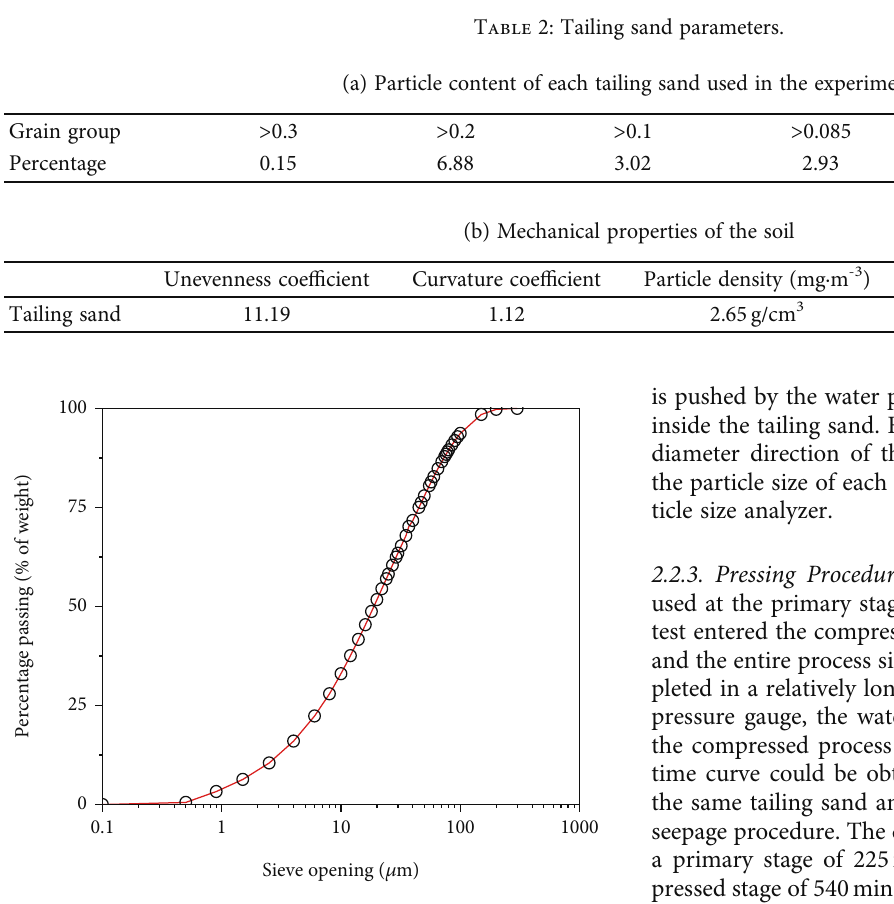
Figure 7: Gradation curve of Jinchuan tailing sand.